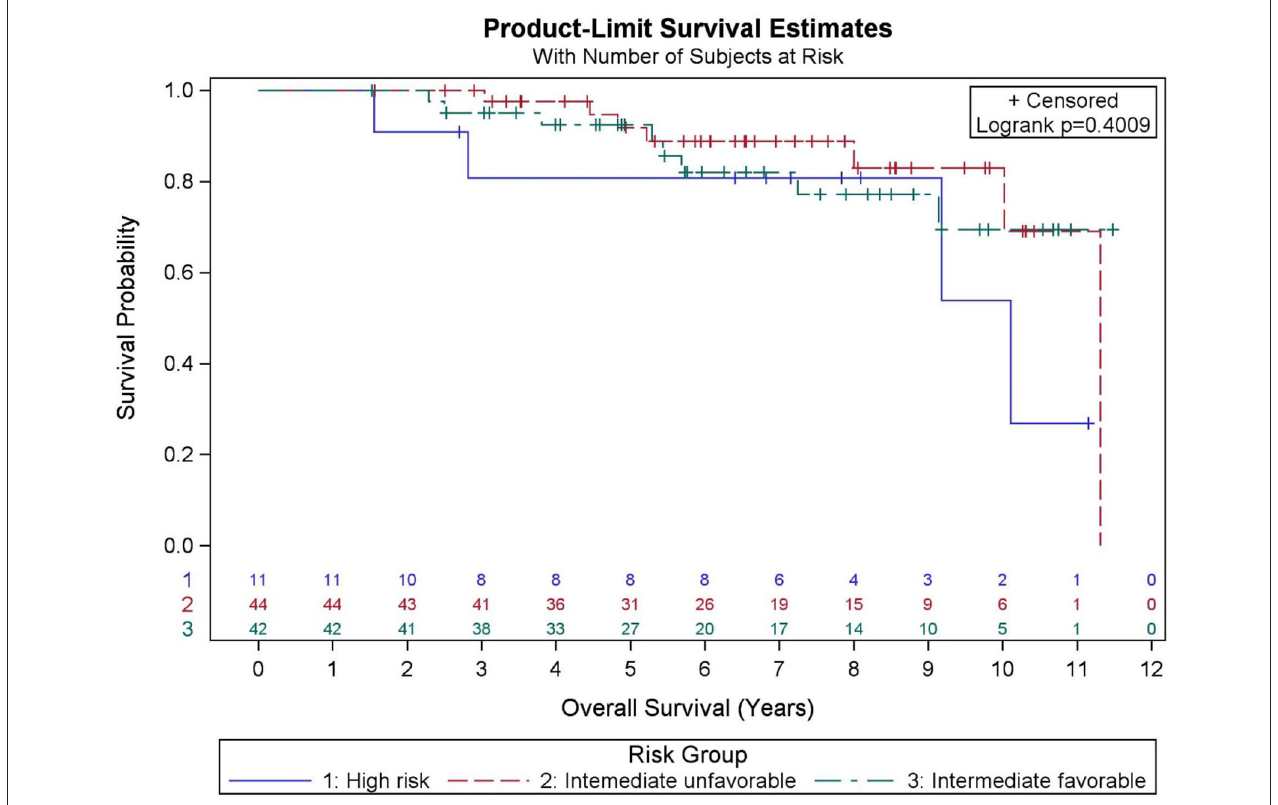
FIGURE 2 | Kaplan–Meier curves for overall survival by risk